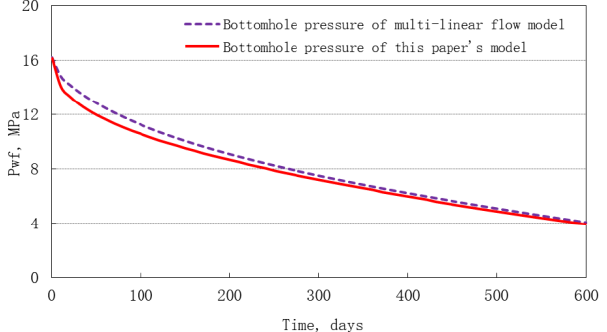
Figure 16. Comparison of this paper’s results with multi-linear flow model results.